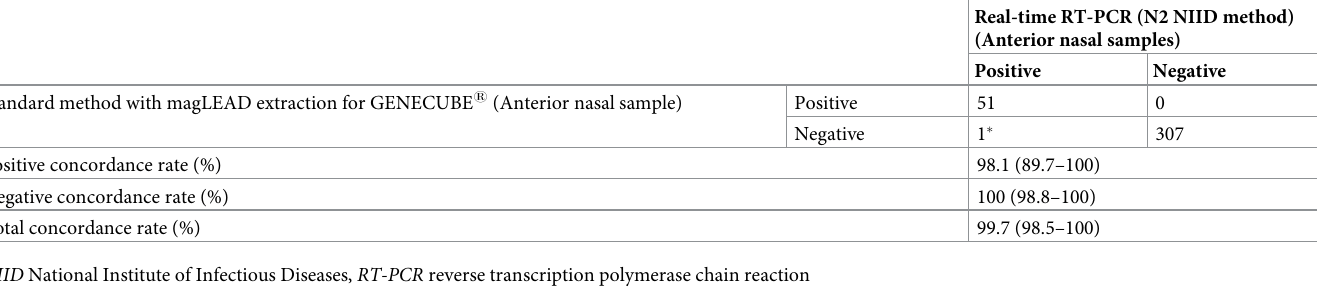
Table 5. Concordance rate of the GENECUBE 1 HQ SARS-CoV-2 with real-time RT-PCR for anterior nasal samples obtained from suspected or confirmed COVID-19 patients.